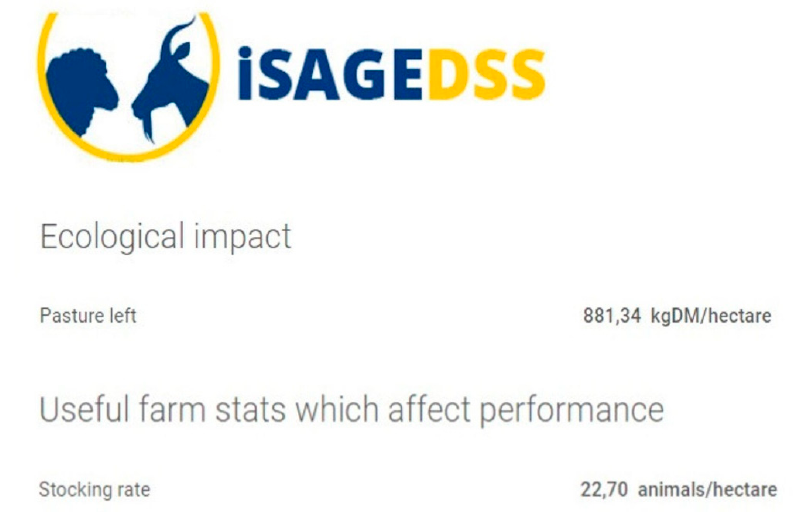
Figure 8. Section of the iSAGEDSS report page with estimated pasture availability at the end of the year and stocking rate; decimal comma is used as the decimal separator.